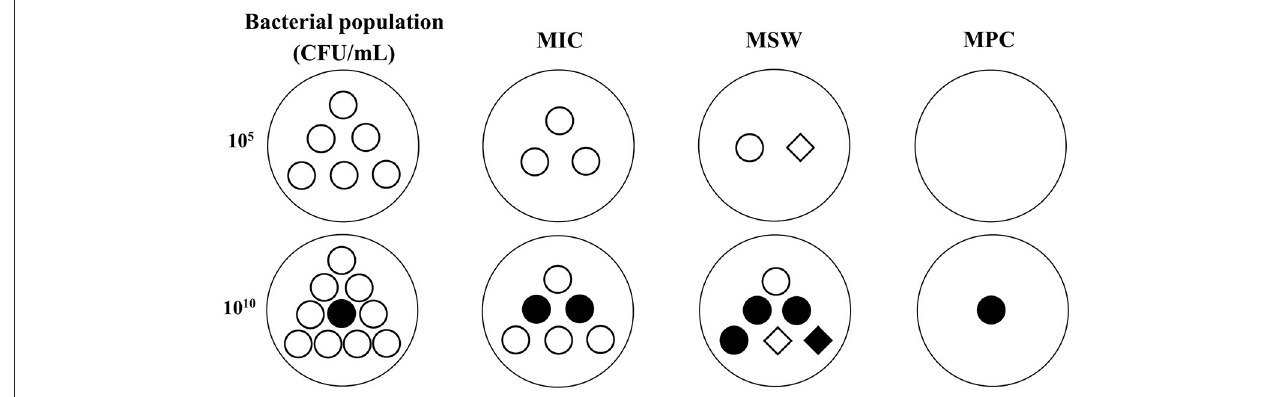
FIGURE 2 | The possible changes of bacterial population and sensitivity under different antibacterial concentrations in low (10 5 CFU/mL) and high (10 10 CFU/mL) inoculums based on MSW theory. ◦ , susceptible bacteria. •, natural mutant bacteria. ♦ , first step mutant bacteria. (cid:7) , multiple step mutant bacteria. MIC, minimum inhibitory concentration. MPC, mutant prevention concentration. MSW, mutant selection window, is the drug concentration between MIC and MPC. In low inoculum, the bacterial population will be gradually reduced with the drug concentrations added from MIC to MPC, and the bacterial sensitivity may be decreased because of the emergence of first step resistant mutation during MSW. In high inoculum, a natural mutant bacteria may exist in the initial population. The total population will be decreased but the mutant subpopulations may be increased when the drug concentrations below MPC. The sensitivity may be obviously decreased because of the emergence of first step and multiple step mutant bacteria during